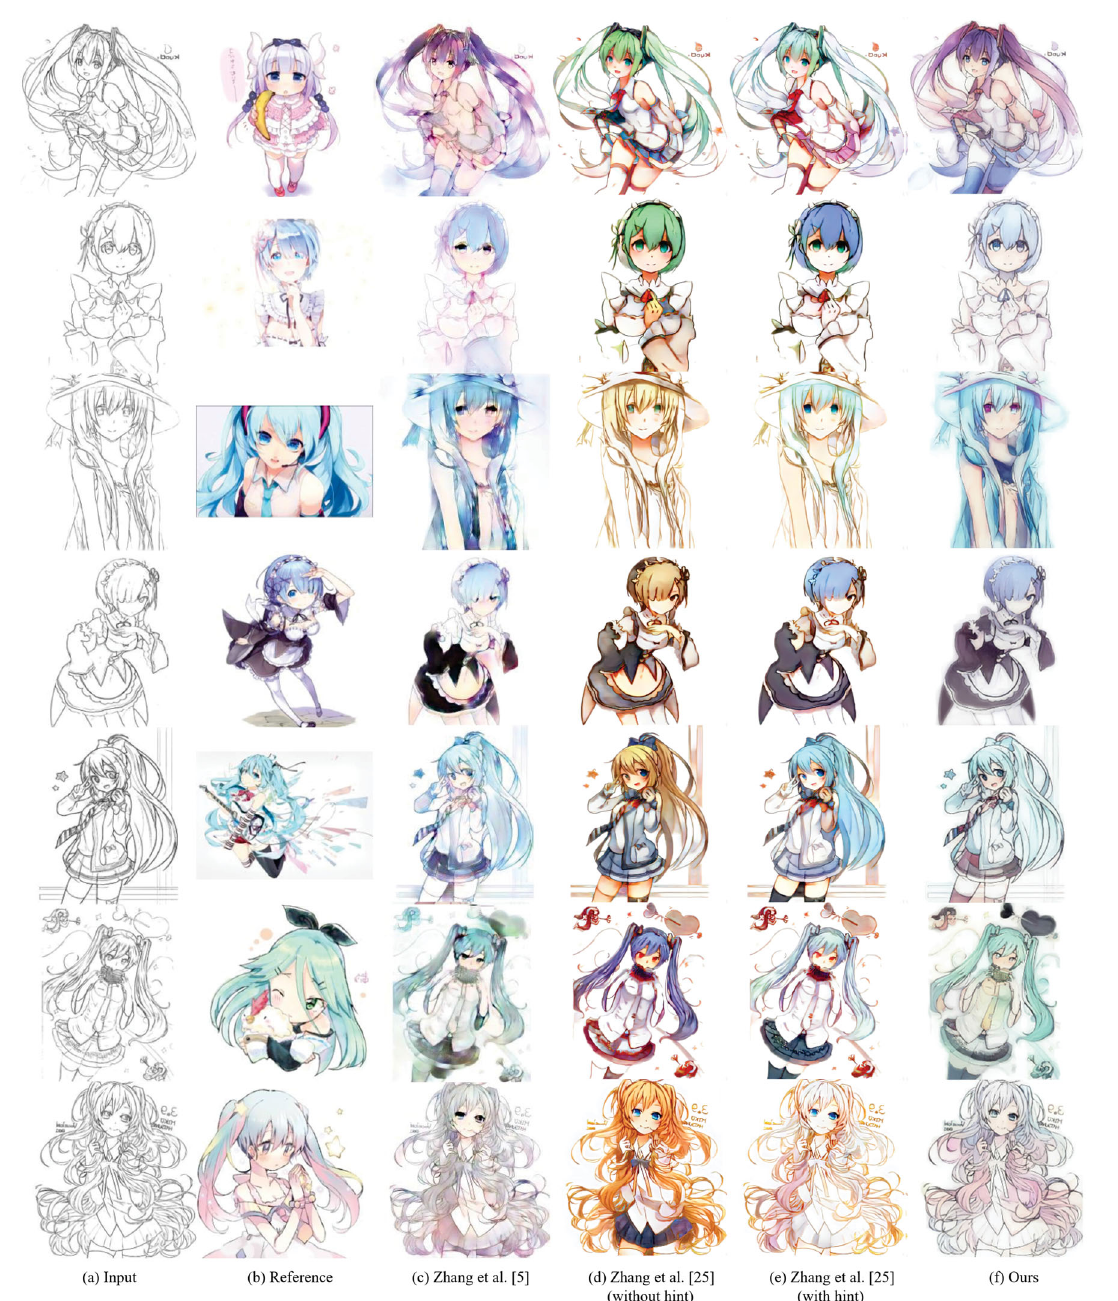
Fig. 6 Visual comparison between our method and state-of-the-art conditional sketch colorization